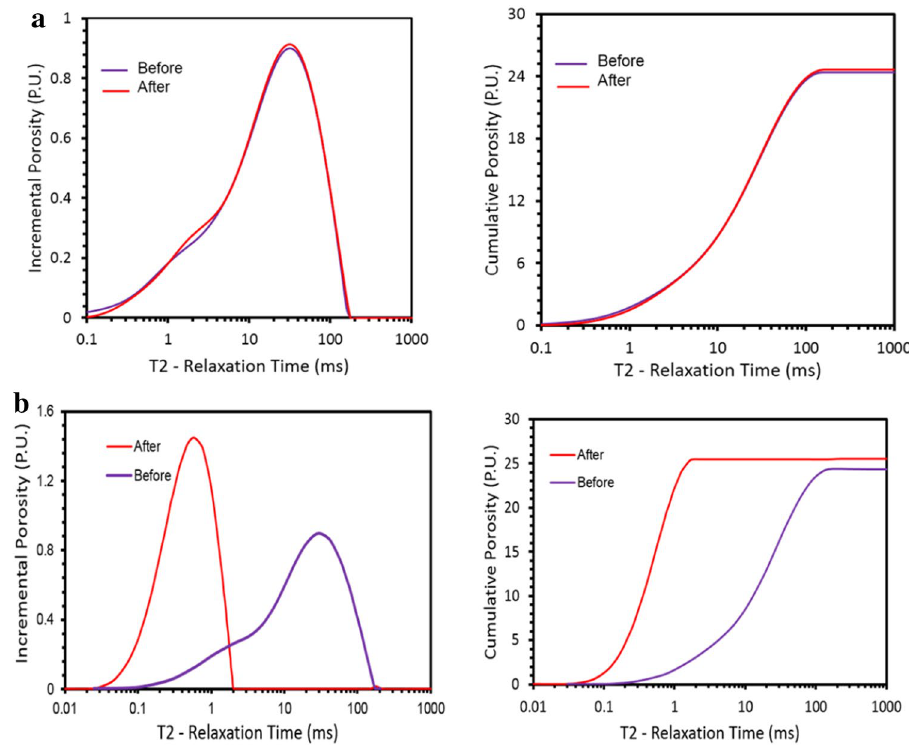
Fig. 9 a NMR T2 response curve for Bandera Brown sandstone core before and after damage at 25 °C using water as a damaging fluid. b NMR T2 response curve for Bandera Brown sandstone core before and after damage at 25 °C using HCl as a damaging